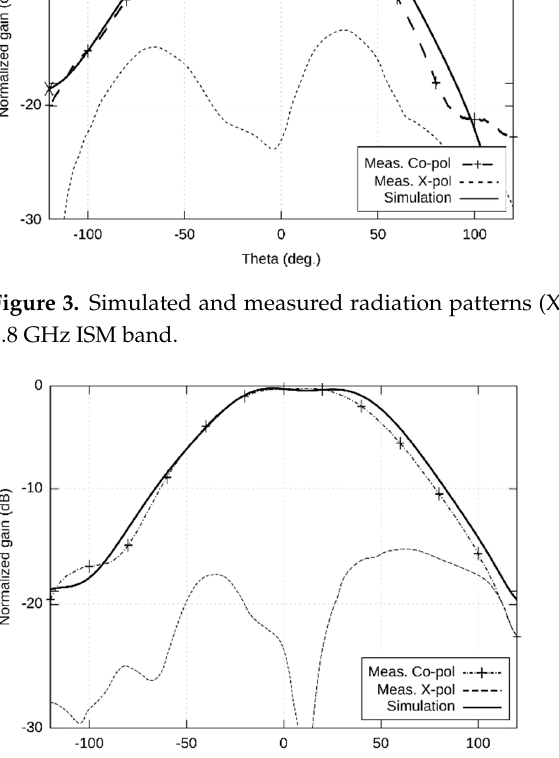
Figure 4. Simulated and measured radiation patterns (YZ plane) of the antenna designed for the 5.8 GHz ISM band.